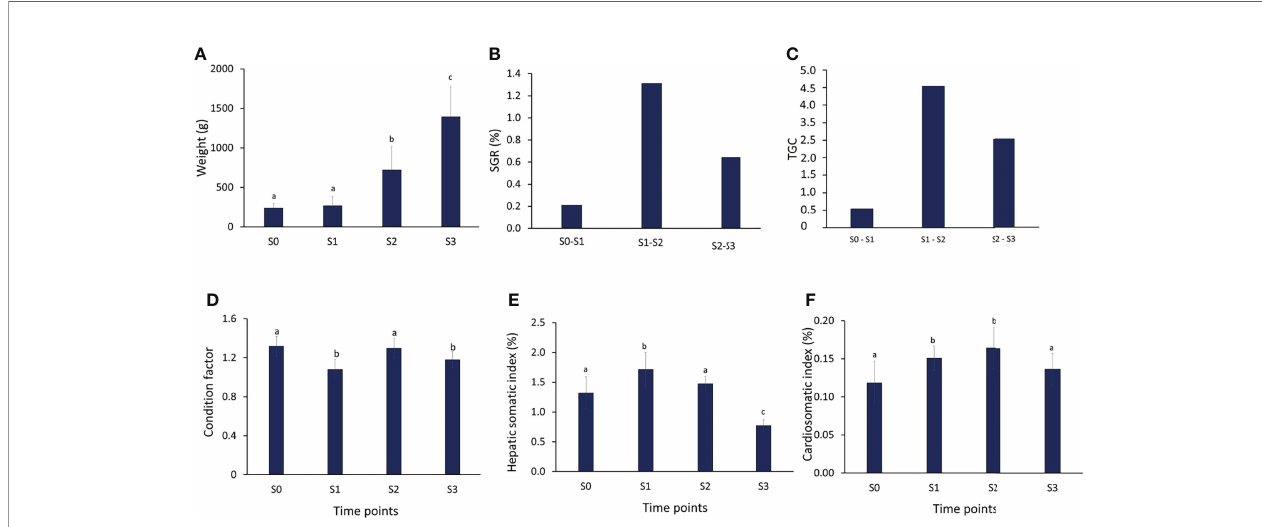
FIGURE 3 | Performance indicators. (A) weight (g), (B) speci fi c growth rate (SGR,%), (C) thermal growth coef fi cient (TGC), (D) condition factor, (E) hepatic somatic index (%) and (F) cardio somatic index of the representative fi sh (N=15) during the 3 phases of production. Values are provided as mean ± SD (A, D – F) . Different letters indicate signi fi cant different at P < 0.05, analyzed by ANOVA followed by a Tukey post-hoc test